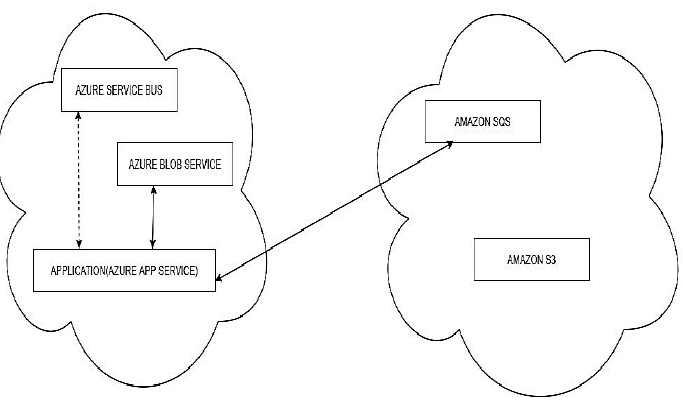
Figure 6. Multi-cloud scenario.